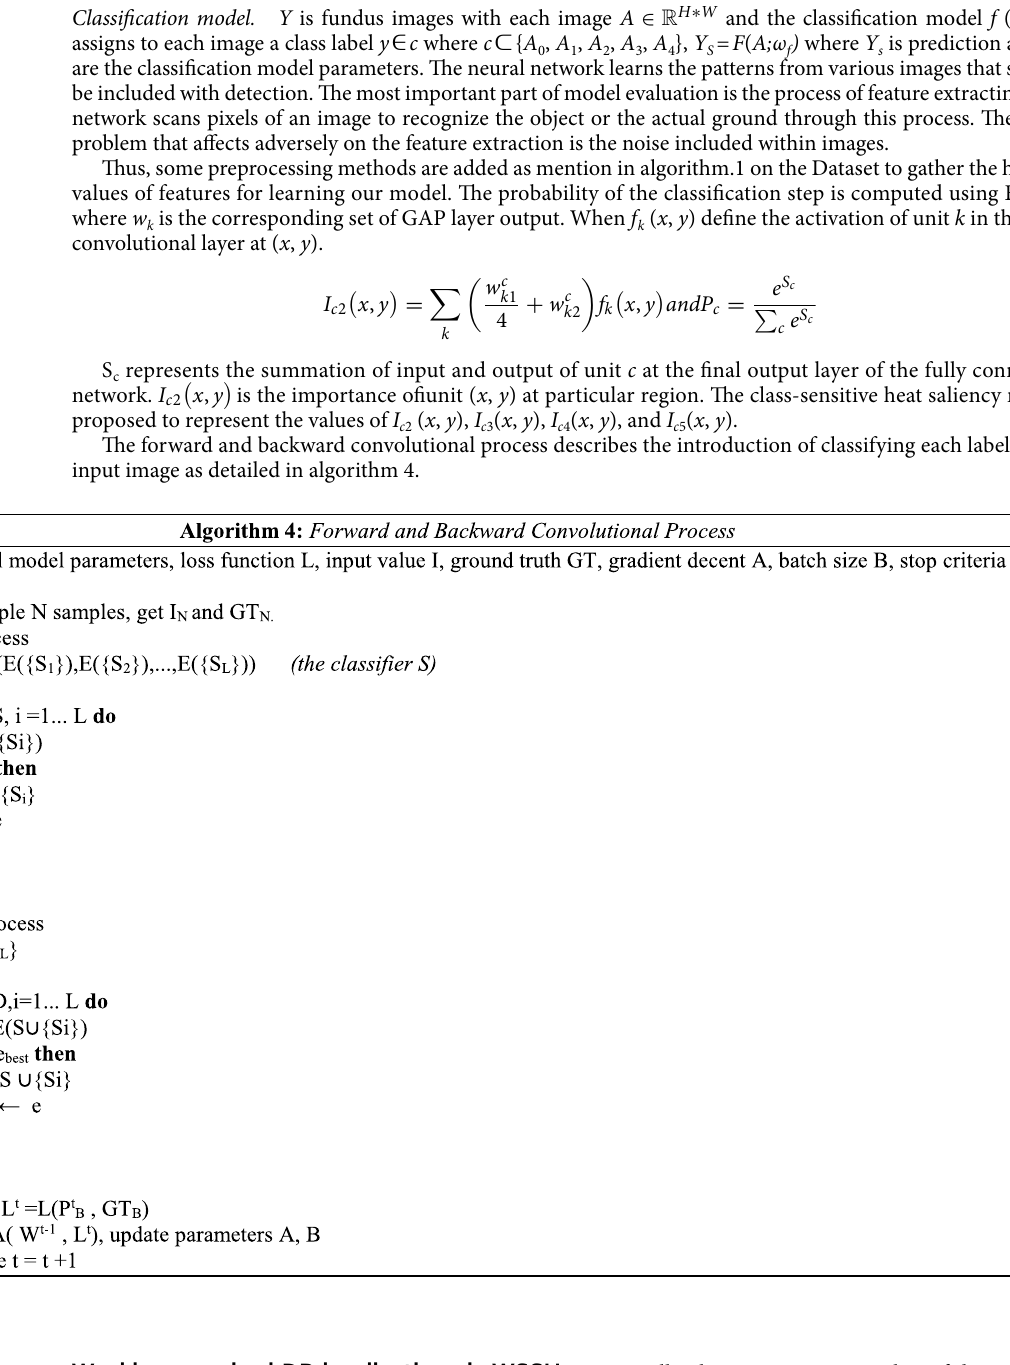
Weakly supervised DR localization via